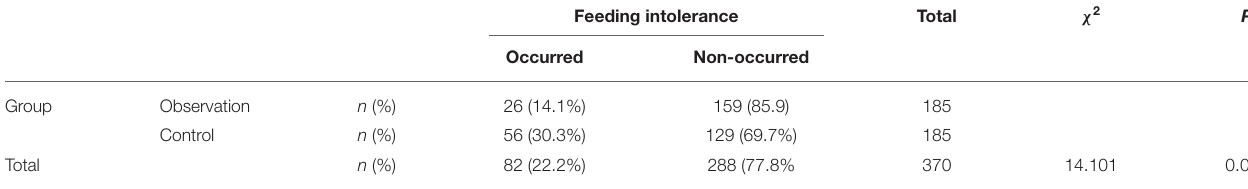
TABLE 2 | Comparison of incidence of feeding intolerance (FI) between the two groups.